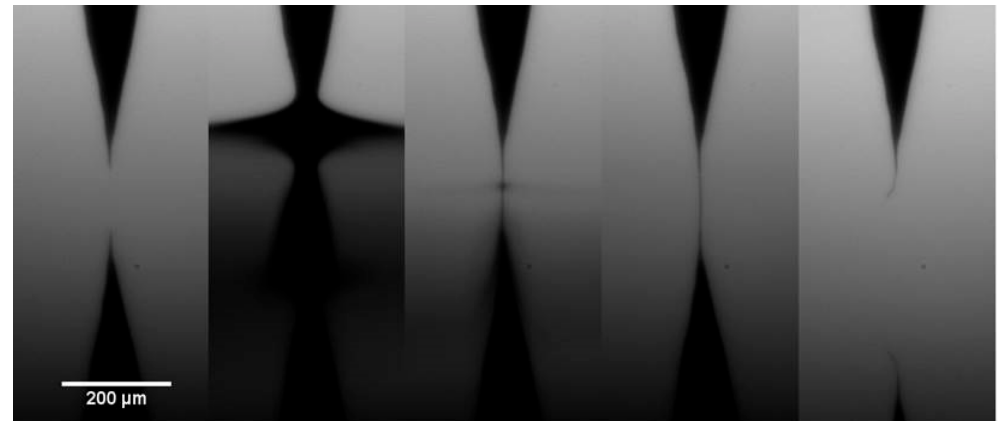
Figure 2. Sequential optical images (left to right) of the tungsten tip and silicon surface, immersed in CNT solution, showing evaporation of the CNT solution and formation of a nanotube fibre with no applied bias.